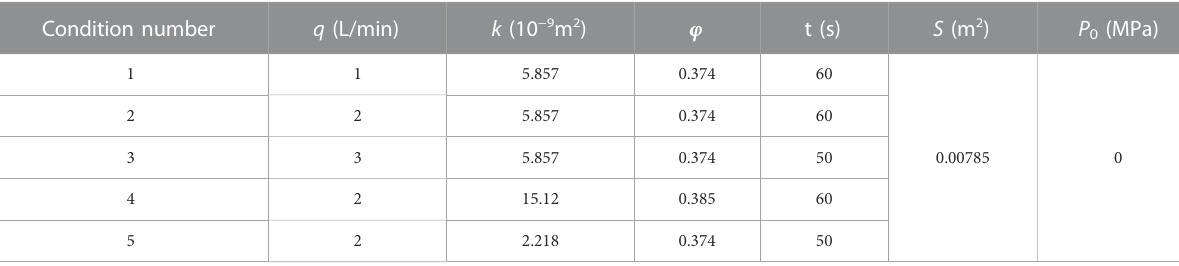
TABLE 3 Calculation parameters of theoretical